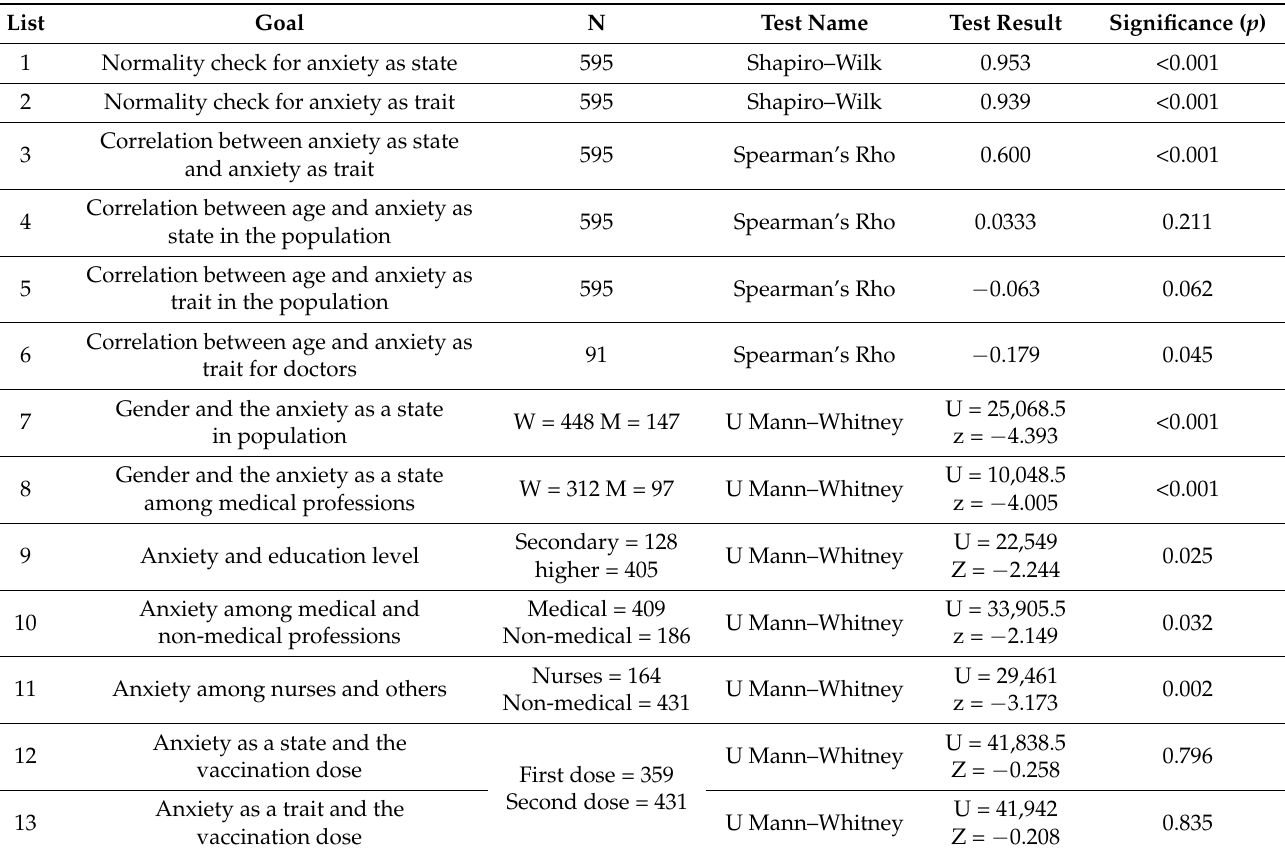
Table 3. Research results—aggregated